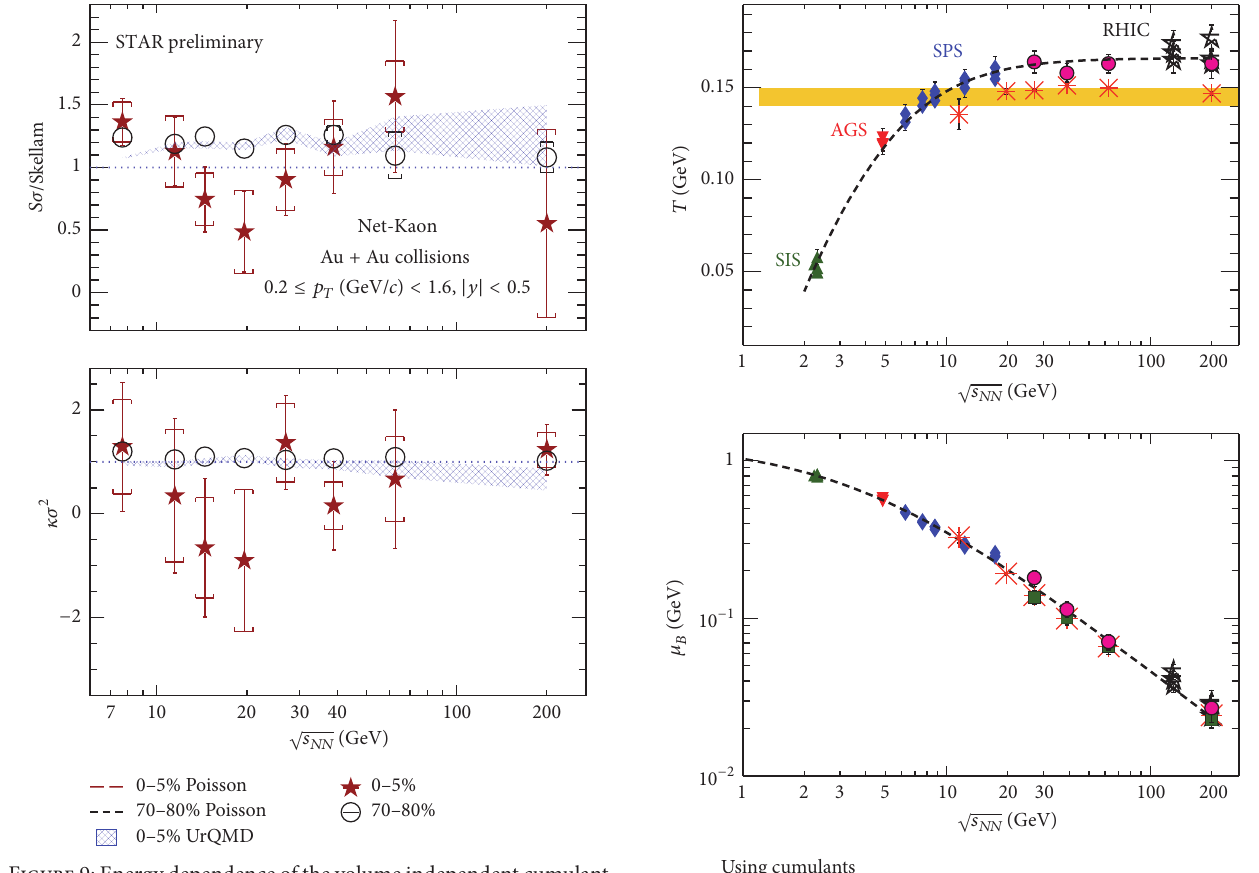
Figure 9: Energy dependence of the volume independent cumulant ratiosofthenet-kaondistributions.Showing 𝑆𝜎 /Skellamand 𝜅𝜎 2 for top 0–5% central (red stars) and 70–80% peripheral (black circles) collisions [67]. The Poisson expectations are denoted as dotted lines and UrQMD calculations are shown as blue bands.